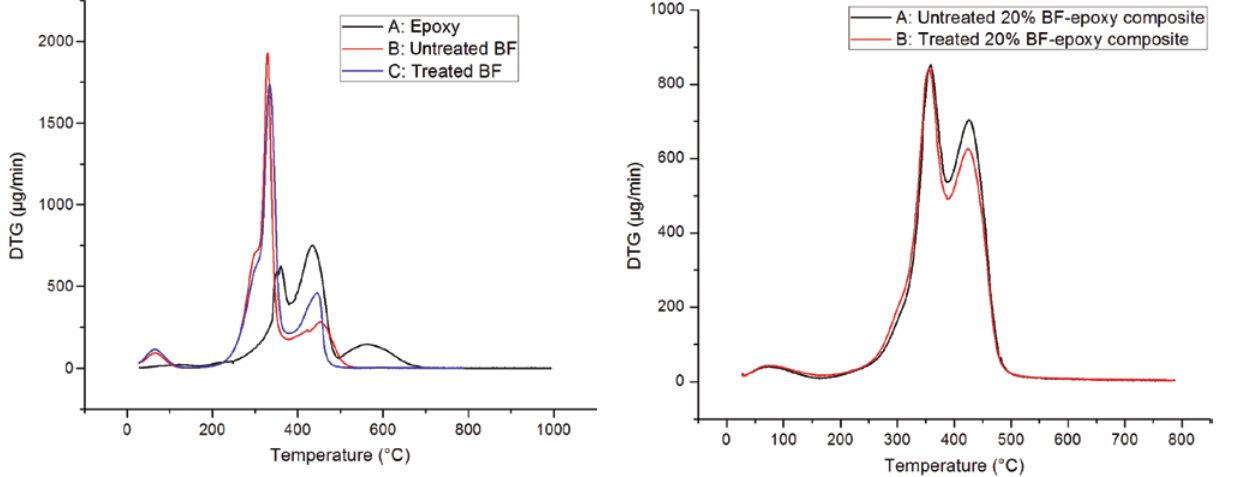
Figure 6: DTG thermogram of epoxy, untreated BF, and treated